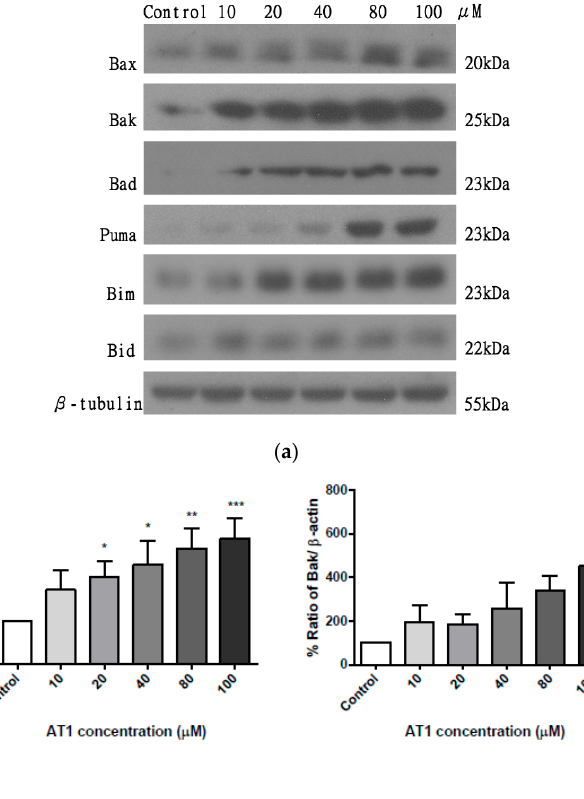
family proteins, Bcl-2 and Bcl-xL, were also analyzed after treatment with various concentrations of AT-I for 48 h. Figure 9a is a representative of three individual experiments; it shows the band intensity of Bcl-2 and Bcl-xL from the western blot experiment. Figure 9b presents the percentage ratio of Bcl- 2 and Bcl-xL versus β -tubulin. The expression level of Bcl-2 decreased to 64.9%, 35.9%, 22.8%, 14.1% and 19.8% of the control after treatment with 10, 20, 40, 80 and 100 μ M, respectively. The expression level of Bcl-xL changed to 97.8%, 110.4%, 106.0%, 94.5% and 97.3% of the control after treatment with 10, 20, 40, 80 and 100 μ M, respectively. The experiment demonstrated that after treatment with AT-I